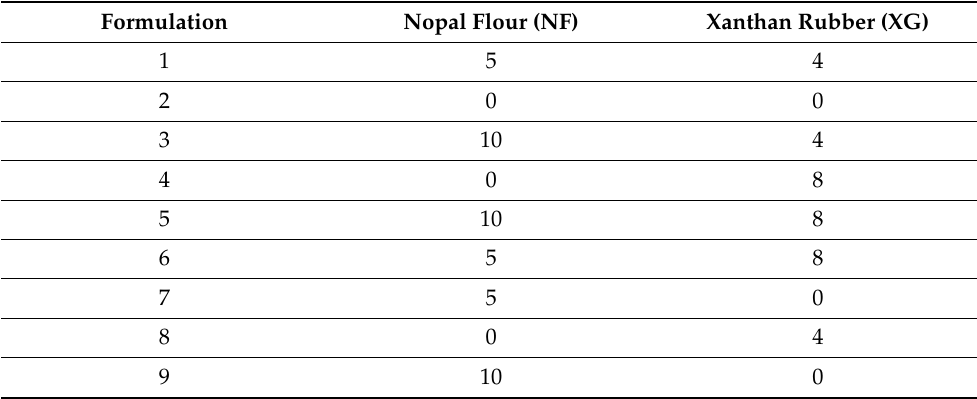
Table 10. Experimental